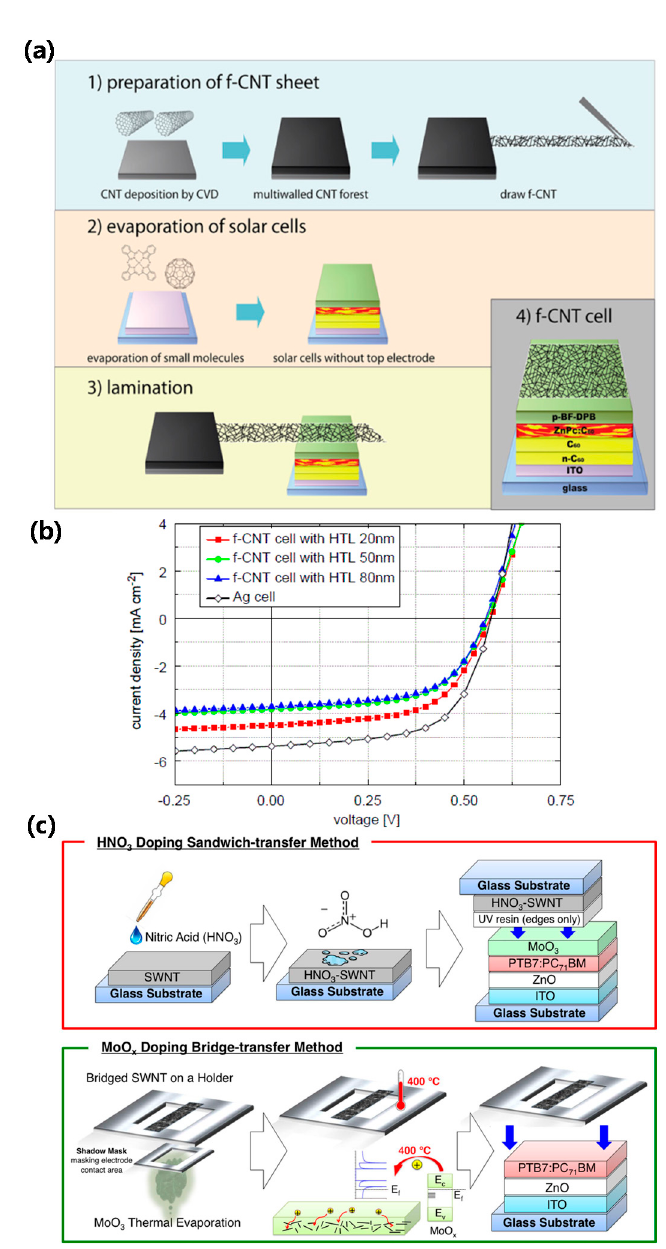
Figure 2. ( a ) Fabrication processes for f-CNT top electrode-based STOSC; ( b ) J - V characteristics of Ag reference cell and f-CNT-based cells with different HTL thicknesses of 20, 50, and 80 nm. Reprinted with permission from [31]. Copyright 2012 Elsevier. ( c ) Schematics of HNO 3 doping sandwich transfer process (above) and MoO x thermal doping bridge transfer process (below). Reprinted with permission from [33]. Copyright 2016 Nature.